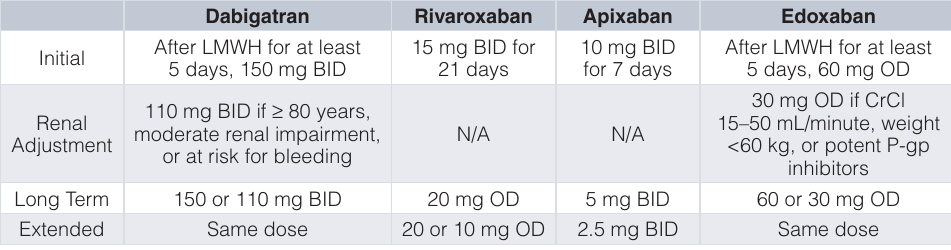
Table 3. Licensed direct oral anticoagulant dosing regimens for the treatment of venous